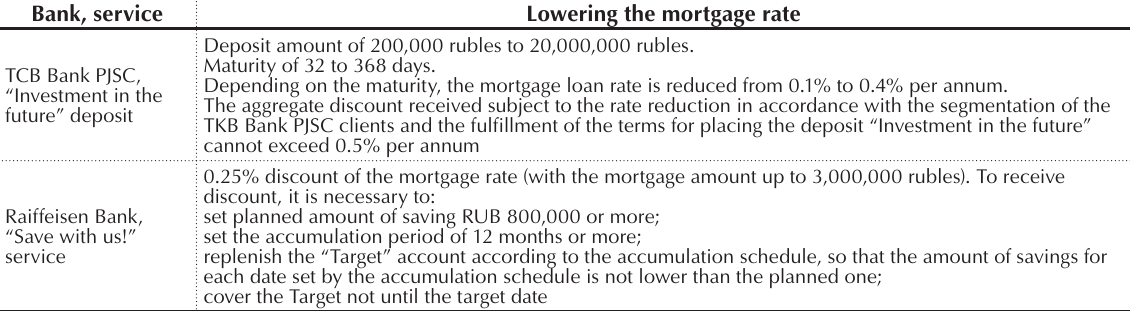
Table 7. (cid:24)(cid:349)(cid:400)(cid:272)(cid:381)(cid:437)(cid:374)(cid:410)(cid:3)(cid:410)(cid:286)(cid:396)(cid:373)(cid:400)(cid:3)(cid:258)(cid:410)(cid:3)(cid:410)(cid:346)(cid:286)(cid:3)(cid:373)(cid:381)(cid:396)(cid:410)(cid:336)(cid:258)(cid:336)(cid:286)(cid:3)(cid:367)(cid:286)(cid:374)(cid:282)(cid:349)(cid:374)(cid:336)(cid:3)(cid:396)(cid:258)(cid:410)(cid:286)(cid:3)(cid:271)(cid:455)(cid:3)(cid:272)(cid:396)(cid:286)(cid:282)(cid:349)(cid:410)(cid:3)(cid:349)(cid:374)(cid:400)(cid:415)(cid:410)(cid:437)(cid:415)(cid:381)(cid:374)(cid:400)(cid:3)(cid:282)(cid:286)(cid:393)(cid:286)(cid:374)(cid:282)(cid:349)(cid:374)(cid:336)(cid:3)(cid:381)(cid:374)(cid:3)(cid:410)(cid:346)(cid:286)(cid:3)(cid:271)(cid:258)(cid:374)(cid:364)(cid:3) (cid:282)(cid:286)(cid:393)(cid:381)(cid:400)(cid:349)(cid:410)(cid:3)(cid:258)(cid:400)(cid:3)(cid:381)(cid:296)(cid:3)(cid:94)(cid:286)(cid:393)(cid:410)(cid:286)(cid:373)(cid:271)(cid:286)(cid:396)(cid:3)(cid:1005)(cid:1004)(cid:853)(cid:3)(cid:1006)(cid:1004)(cid:1005)(cid:1010)